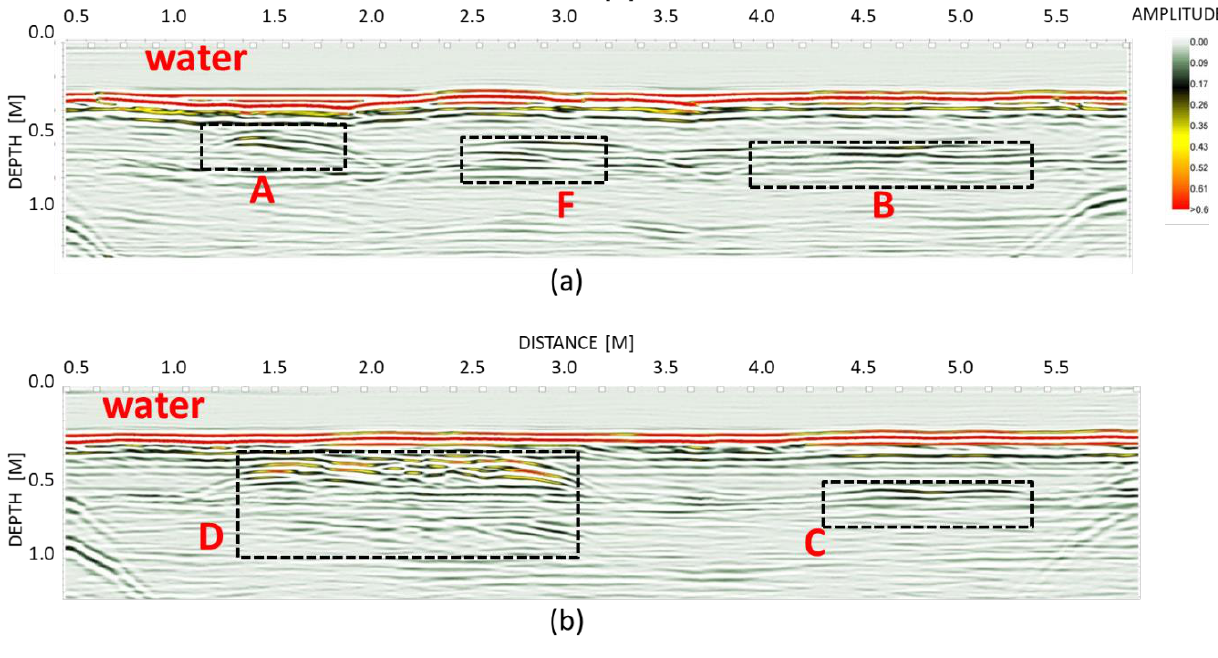
Figure 13. 2D radargrams obtained along the S1 ( a ) and S2 ( b ) profiles in Figure 5 with indication of the anomalies related to the archaeological structures.